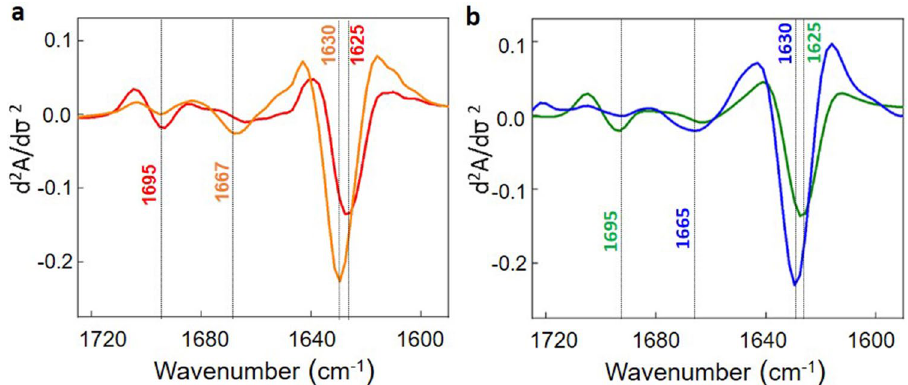
Figure 2. Average second derivative spectra of the amide I region of ( a ) Aβ(1–40) and ( b ) Aβ(1–42) amyloid aggregates generated in vitro: fibrils (orange and blue respectively) generated at pH 7.4 and Aβ granular non- fibrillary aggregates (red and green respectively) generated at pH 5.5. The absorbance spectra were normalized for the amide I area prior to derivation. Origin 9.1 and Microsoft power point 2016 software were used for graphical